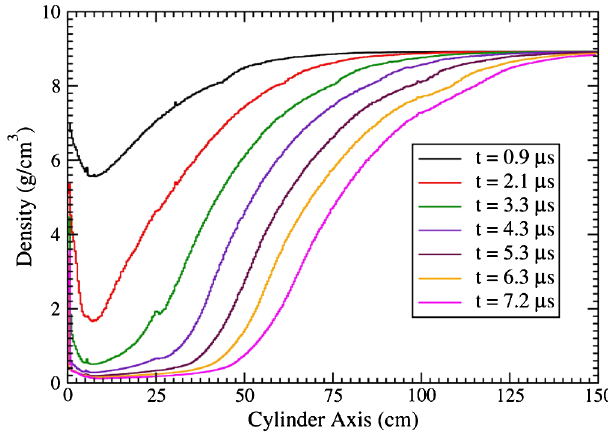
FIG. 17. Density profiles along the axis at different times in the cylindrical copper target, r ¼ 5 cm , L ¼ 1 : 5 m , irradiated by the 440 GeV SPS proton beam with (cid:1) ¼ 0 : 1 mm